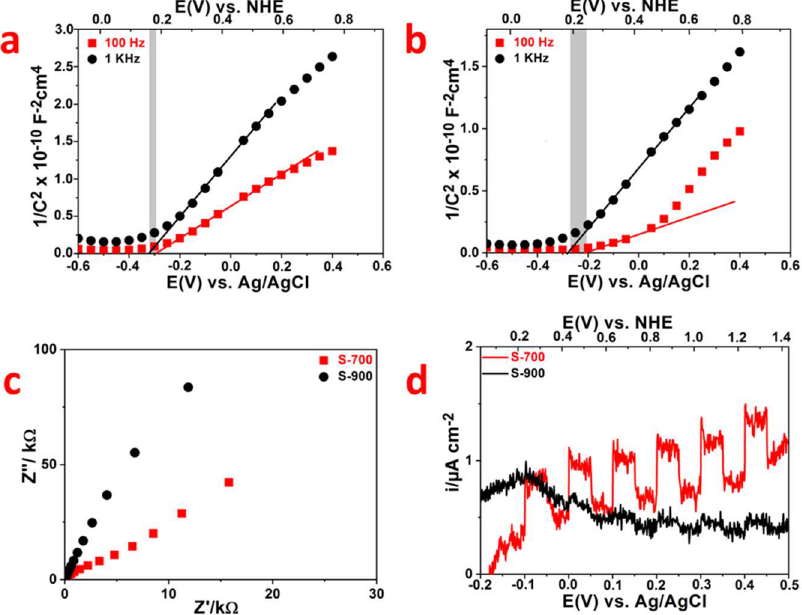
Figure 8. Mott-Schottky plots at 100 Hz and 1 kHz of ( a ) S-700 and ( b ) S-900, ( c ) Nyquist plots of S-700 and S-900 in 0.1 M Na 2 SO 4 (pH = 5.6) at 0.4 V vs. Ag/AgCl and ( d ) transient photocurrent responses in 0.1 M Na 2 SO 4 /0.1 M Na 2 SO 3 solution (pH = 5.6) under white LED illumination.